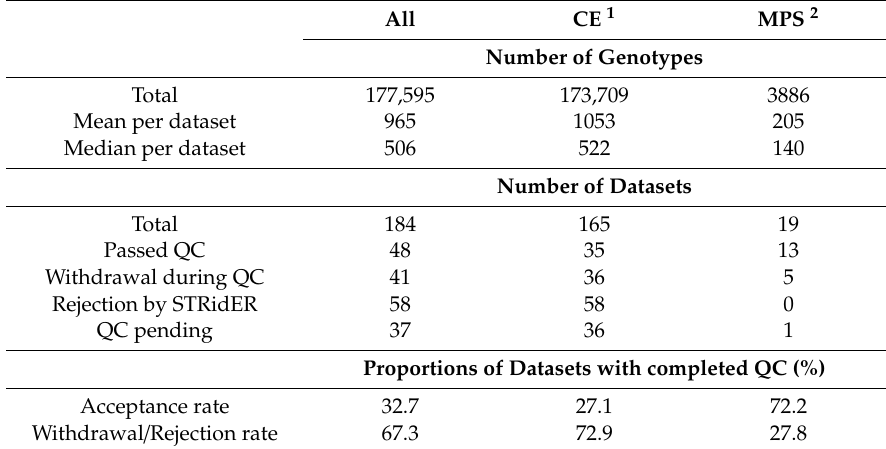
1 Length-based genotypes generated by capillary electrophoresis (CE). 2 Genotypes generated by massively parallel sequencing (MPS). Note: Results as per six months after the initial two-year period. QC, quality